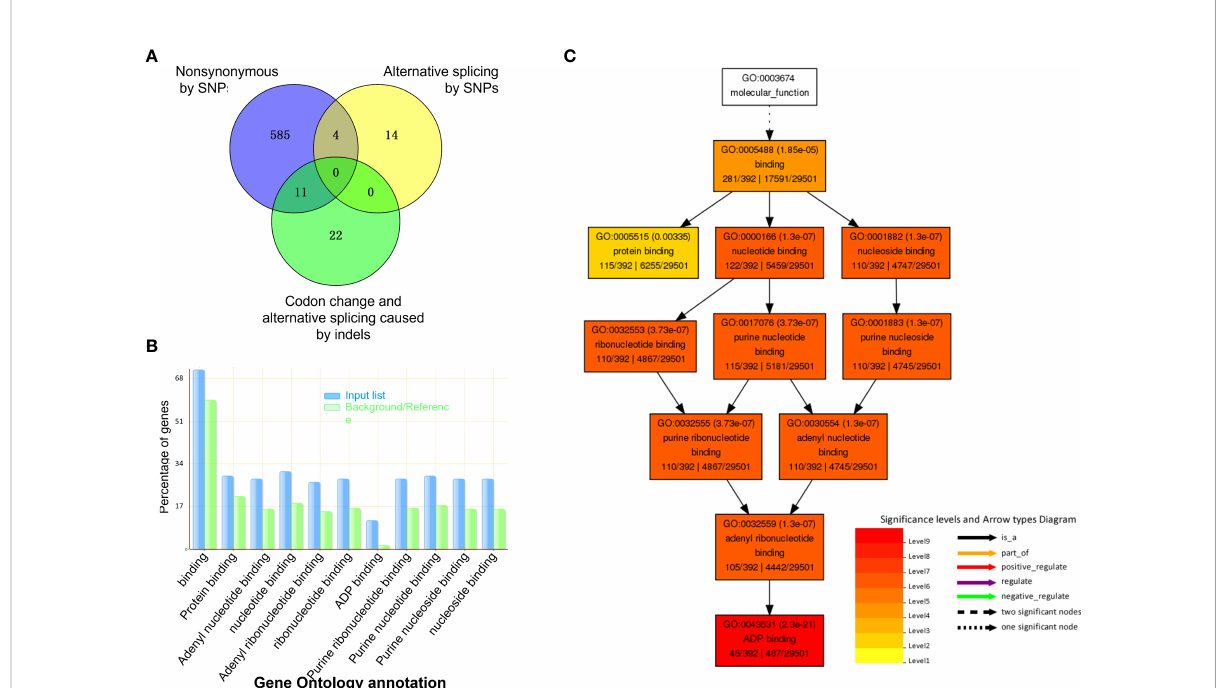
FIGURE 3 Gene Ontology (GO) analysis of mutated genes with InDels and SNPs. (A) Venn graph shows the number of genes in three types of predicted effects from mutations. (B) GO terms enriched by Fisher test at signi fi cance level< 0.05 and 5 minimum number of mapping entry. (C) Hierarchy structure of enriched GO